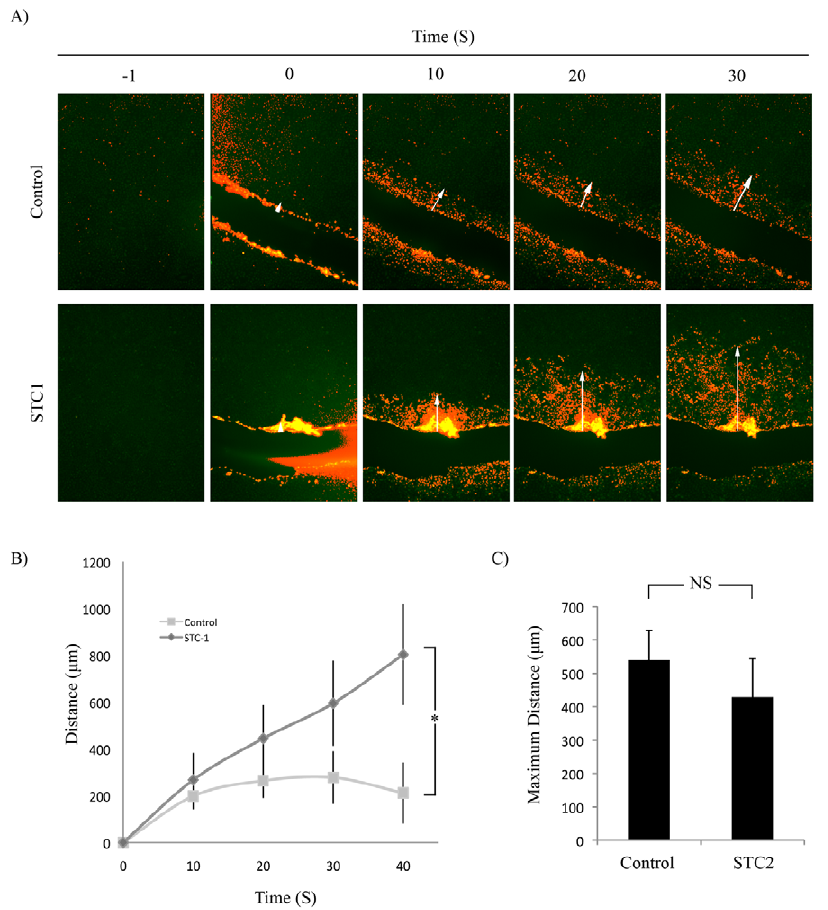
Figure 1. STC1 Enhanced Calcium Wave Propagation Following Mechanical Injury. A) Confluent A549 monolayers were labeled with Fluo- 4 and pre-incubated with or without 500 ng/mL STC1 for 10 min prior to mechanical disruption. Shown are images obtained 2 1, 0, 10, 20 and 30 s post-disruption. Images in each group were manipulated equally using the threshold function in Adobe Photoshop in order to false color the wave for clarity (red). Arrow points to leading edge of wave. B) Mean distance traveled by calcium wave over time in control and STC1 treatment groups from A. Error Bars = SD. * = p , 0.05. n=5 movies. C) Mean maximum distance reached by calcium wave with or without pretreatment with 500 ng/ mL STC2. NS=Not significant.